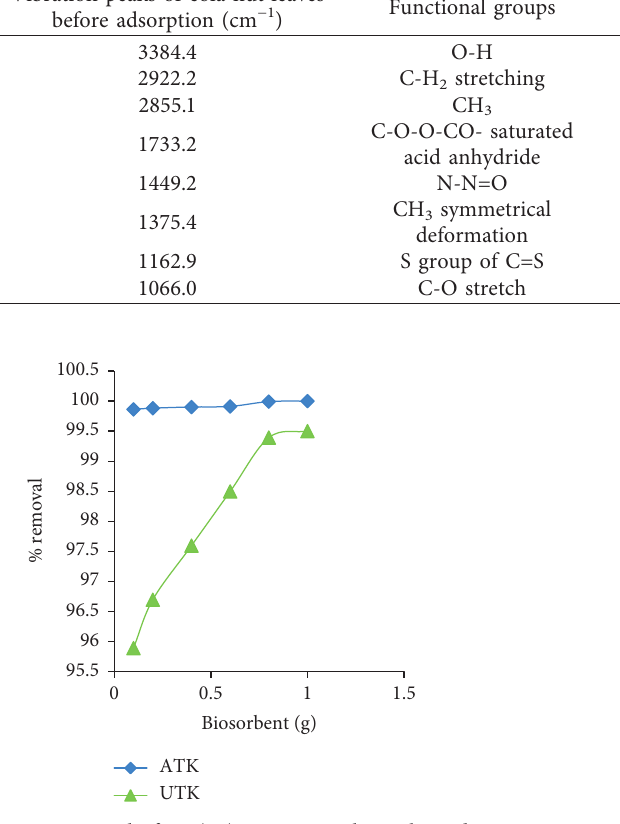
Figure 1: % removal of Cr (VI) ions versus biosorbent dose.